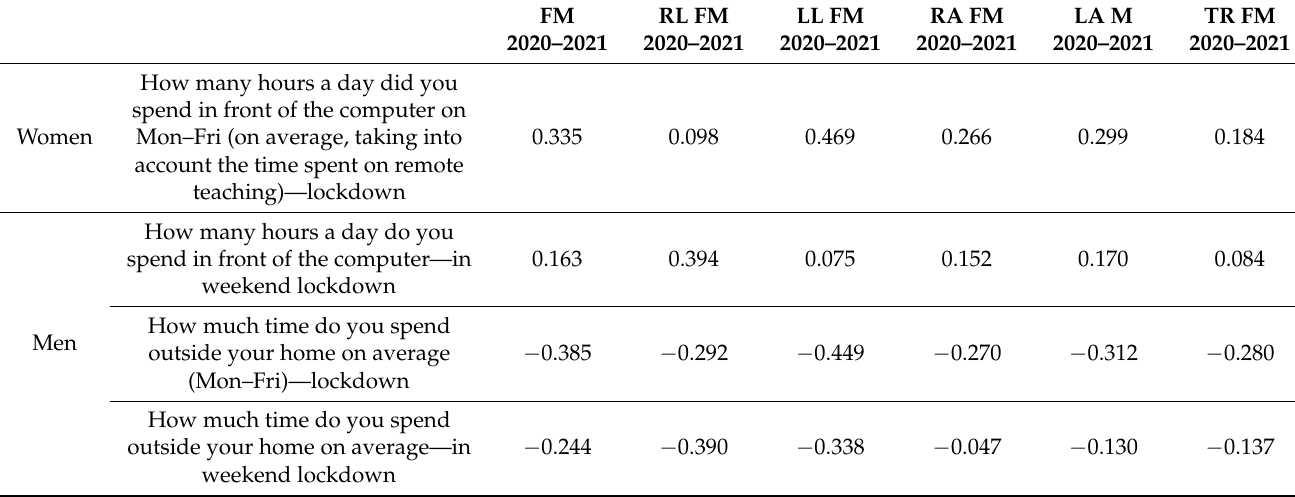
Table 3. Correlation of time spent in front of the monitor and away from home and the change in body fat in the study group.